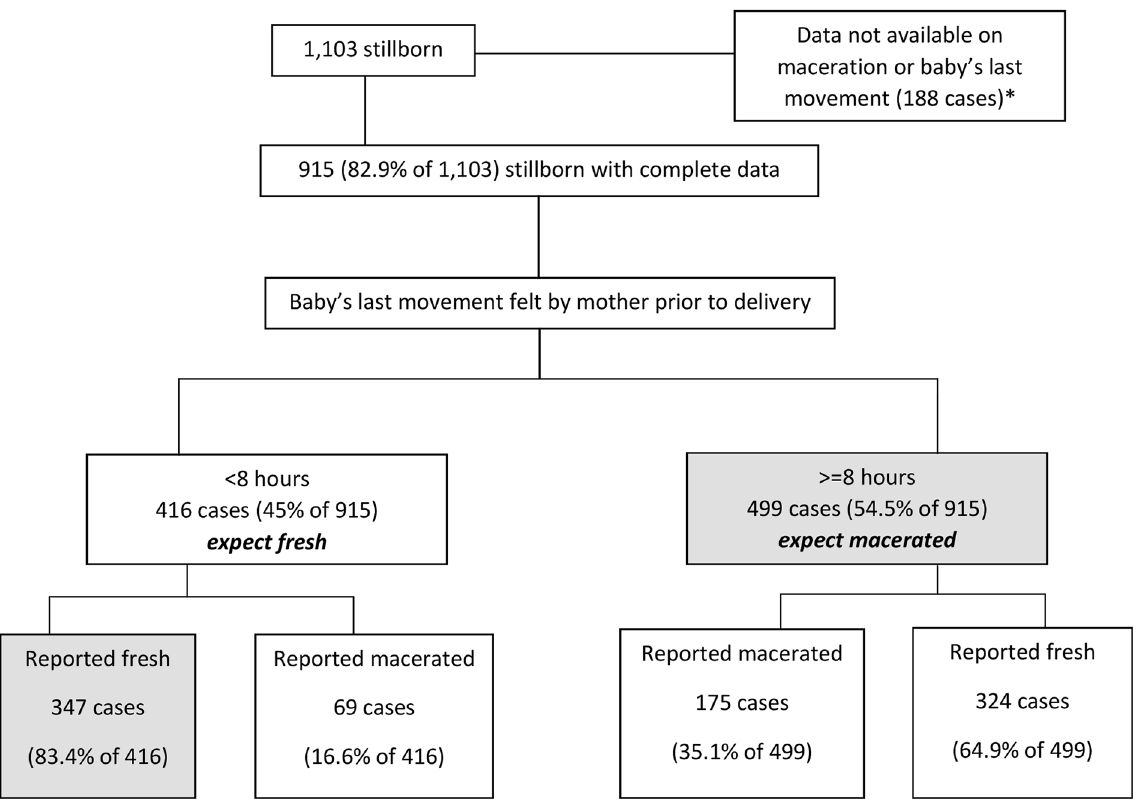
Fig 3. The classification process used to identify antepartum and intrapartum deaths for the stillbirths in the Indian state of Bihar. * Skin appearance and the baby’s movement were reportedas “do not know” for 96 and 116 cases, respectively.For an additional 24 cases, both were reportedas “do not